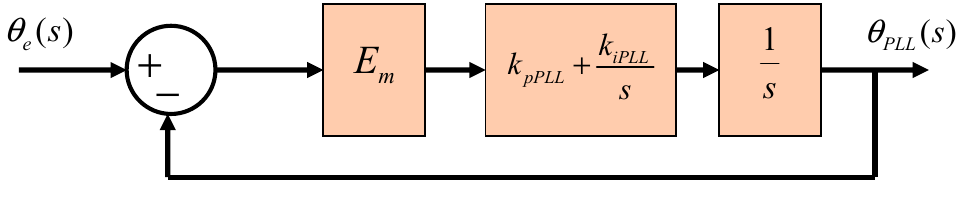
Figure 1. PLL linear model .